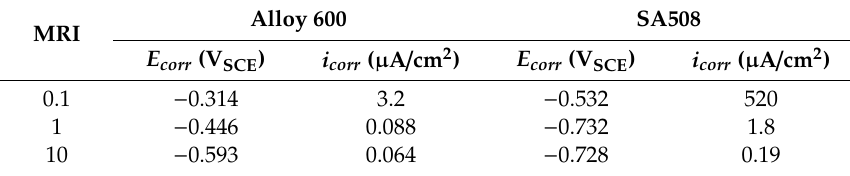
polarization polarization tests.